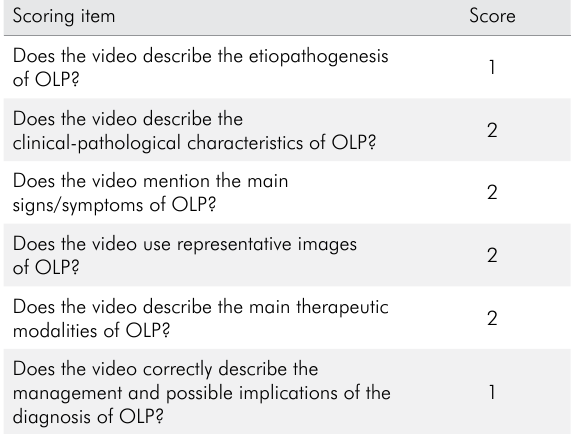
Figure. Flow diagram the identification and screening process of the included videos.